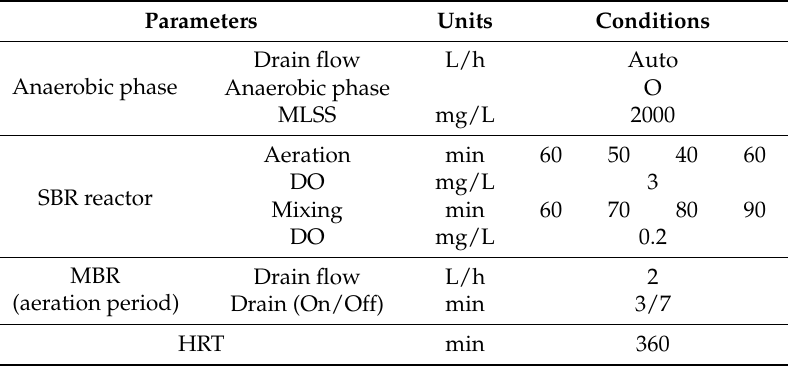
Table 2. The detailed operating conditions of the reactor.